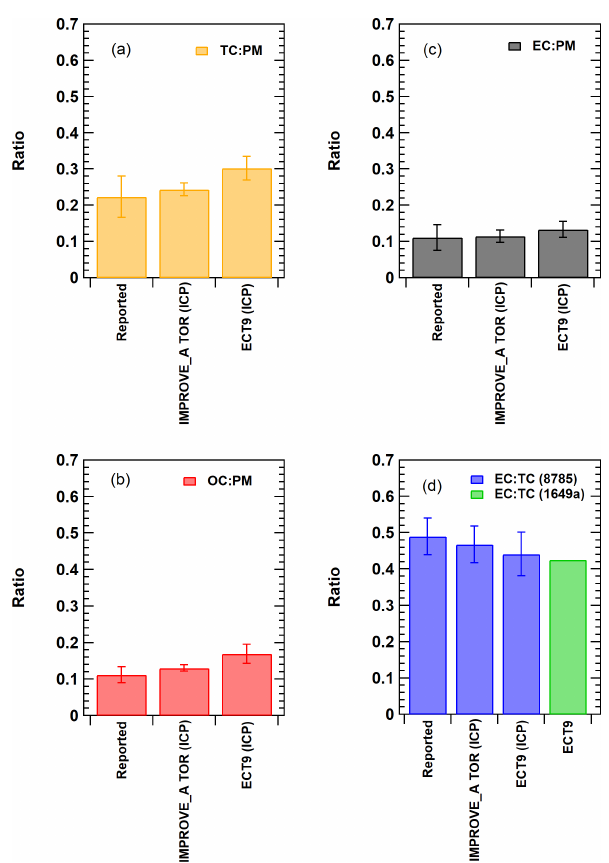
Figure 2. Comparison of the TC, OC, and EC measurements of the NIST SRM samples reported by the ECCC and DRI groups during the inter-comparison study (ICP) conducted between 2009 and 2010. “Reported” represents the published value in the NIST SRM certificate (Cavanagh and Watters, 2005). Error bars repre- sent uncertainties covering the 95% confidence interval. In (d) , the ECT9 value (in green) represents the calculated EC / TC ratio deter- mined based on stable carbon isotope measurement obtained from the SRM 1649a sample (Currie et al.,